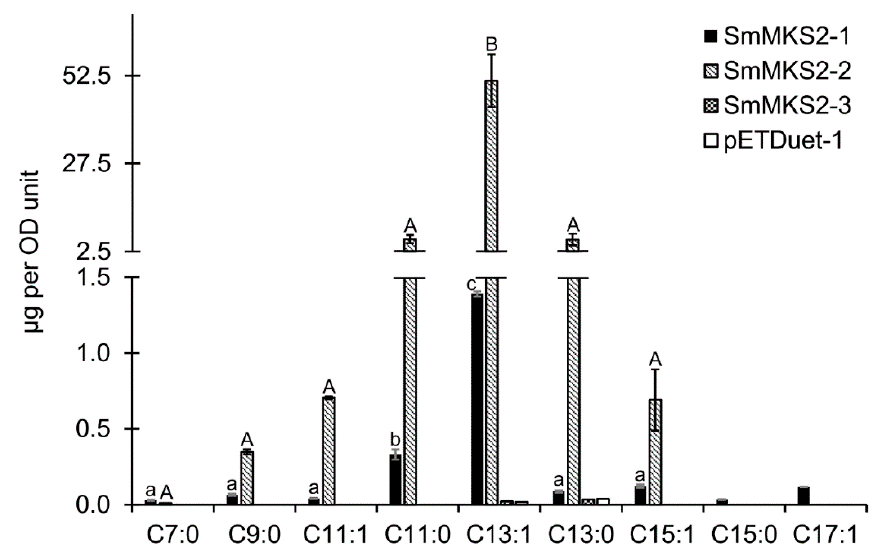
Figure 6. Quantification of 2-methylketones detected following heating the culture of E. coli cells E. coli cells carrying an empty vector, or expressing SmMKS2-1, SmMKS2-2, SmMKS2-3. Cells were grown and media were collected and treated as described in “Materials and Methods.” 2-Methylketones, which were derived from β -ketoacids, were quantified by comparison of peak areas to a linalool internal standard using GC. Values are averages ± SE calculated from three replicates. Significant di ff erences were assessed by one-way ANOVA followed by Tukey’s test. Bars of the same pattern with di ff erent letters are significantly di ff erent ( p < 0.005).